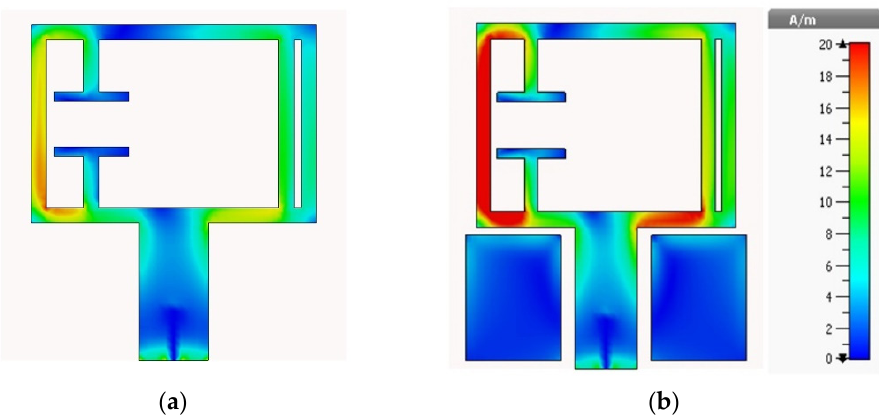
Figure 10. Surface current distribution of ( a ) Antenna 3 and ( b ) Antenna 4 at 3.6 GHz and 3.8 GHz, respectively. The equivalent circuit of the structure can be approximated as shown in Figure 11.